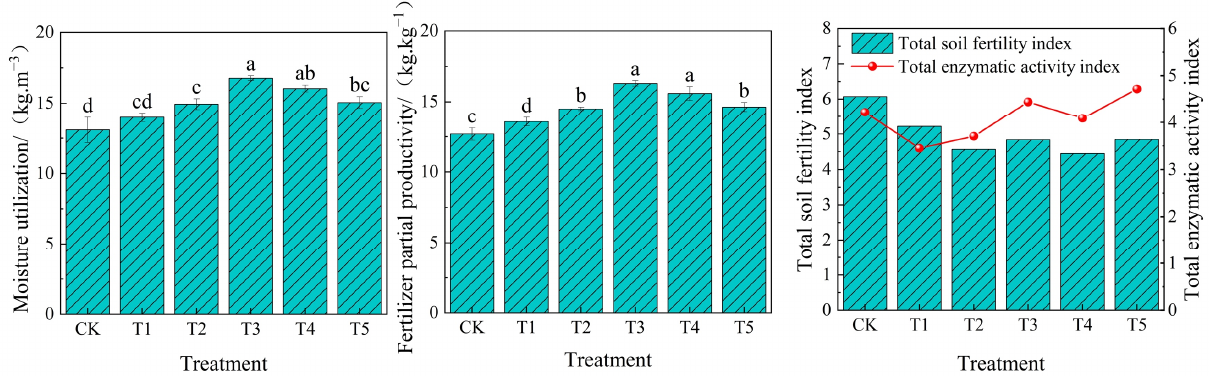
Figure 7. Effects of different treatments on water and fertilizer use efficiency Error bars represent ± SD. Values followed by the same letter within a column in each year are not significantly different at p ≤ 0.05, as determined by the HSD test.